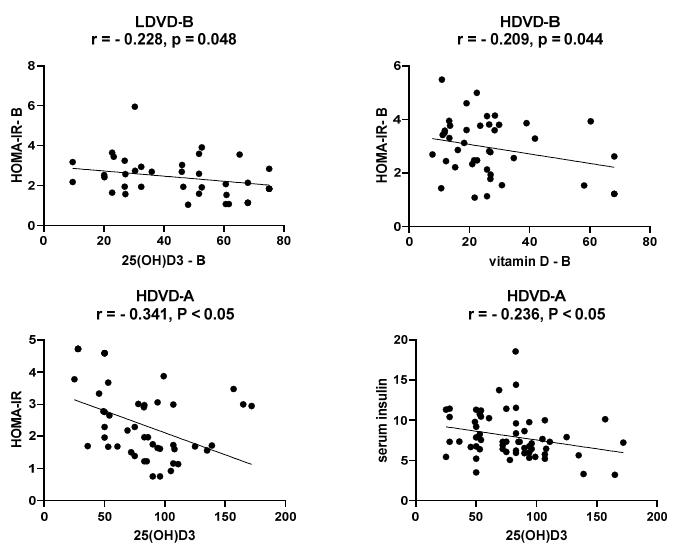
Figure 4. Inverse correlation between serum 25(OH)D3, insulin, and HOMA-IR in LDVD and HDVD group before (B) and after (A) three months of vitamin D supplementation (50,000 IU).